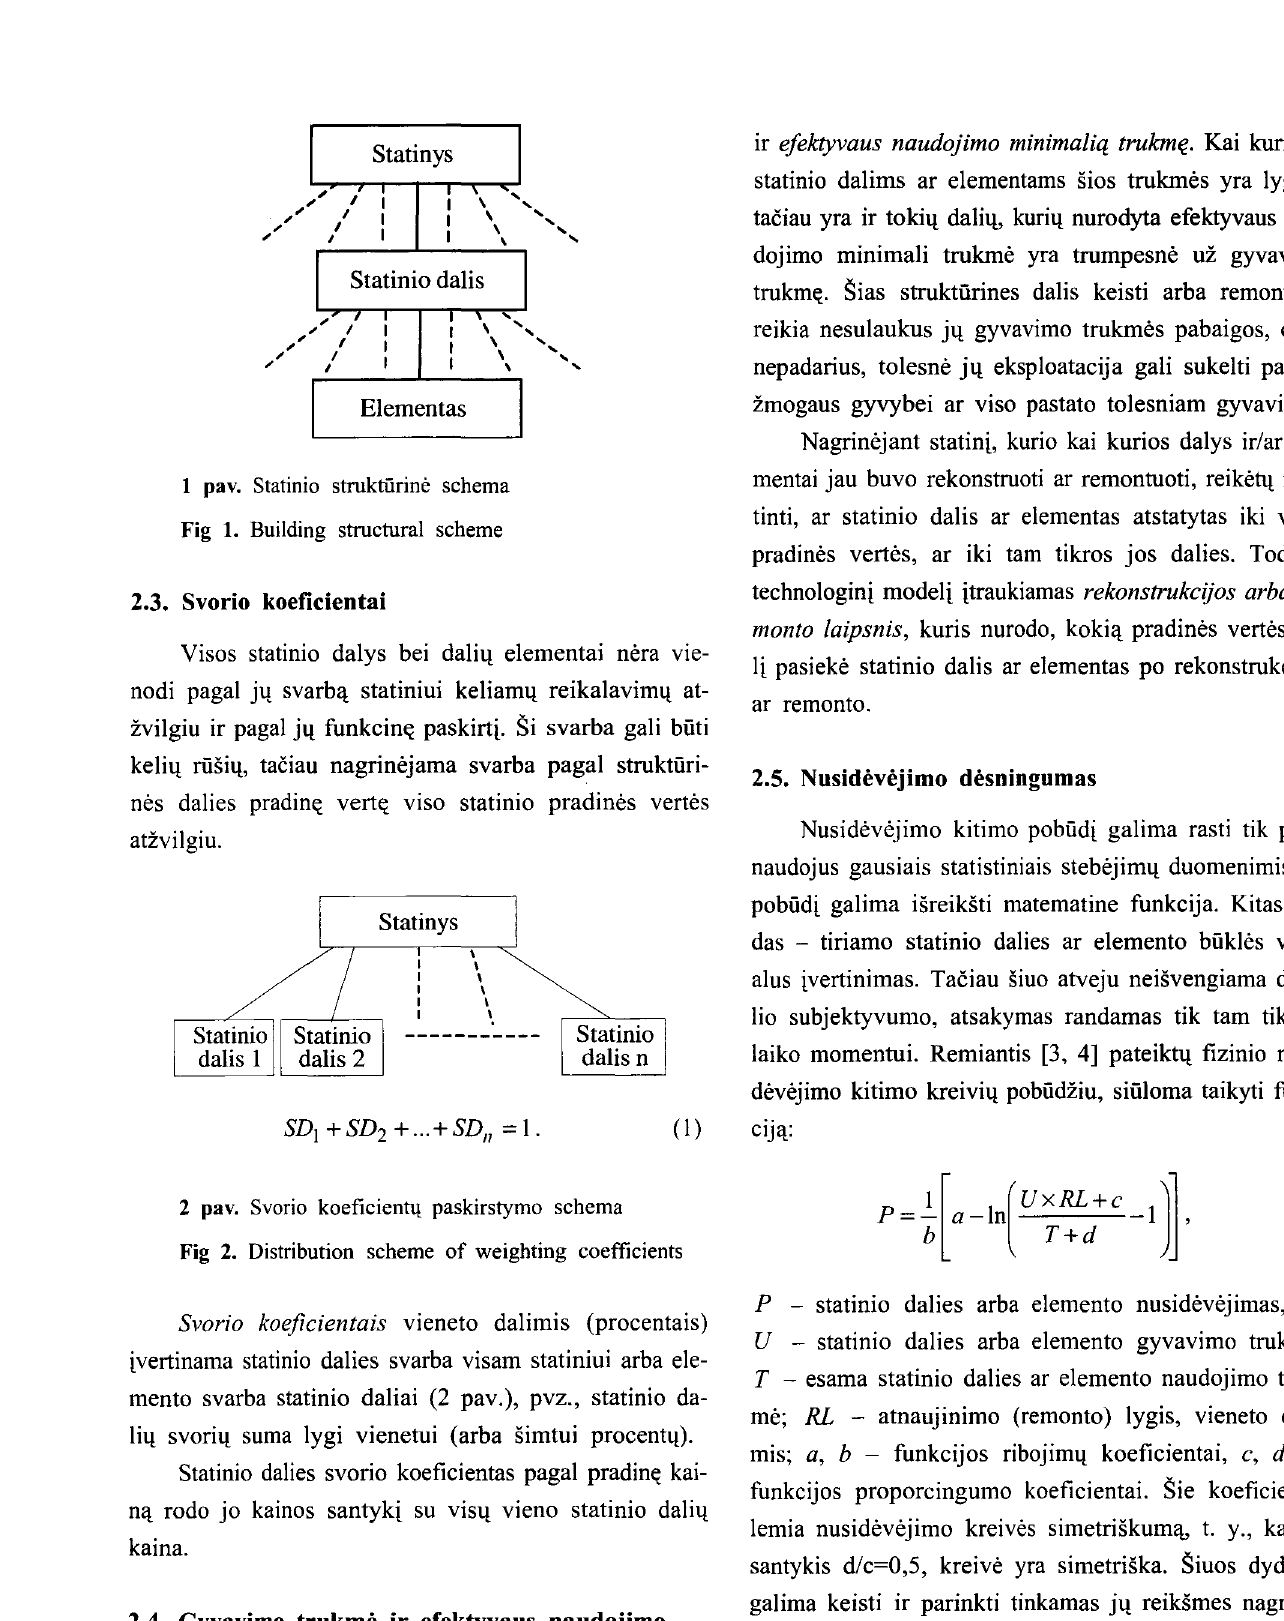
Fig 2. Distribution scheme of weighting